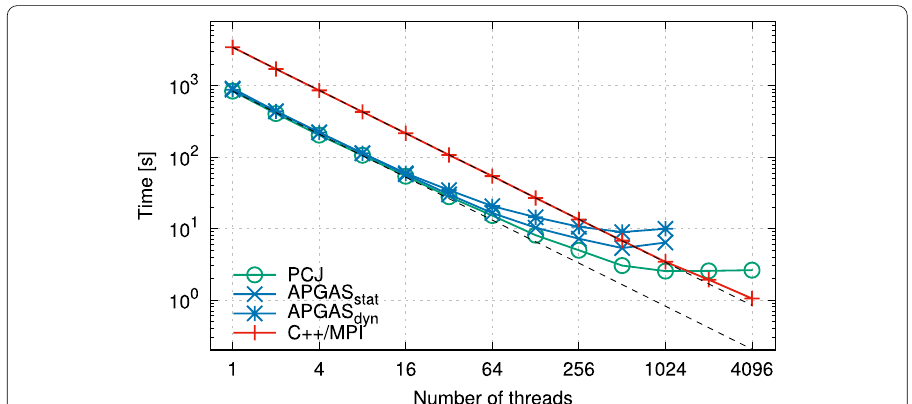
Fig. 7 Strong scalability of WordCount application implemented in PCJ and APGAS. APGAS stat and APGAS dyn denote original fork-join algorithm and algorithm using lifeline-based global load balancing. C /MPI ++ results are plotted for reference. Ideal scaling for PCJ and C /MPI are drawn with the dashed lines. The ++ results are presented for 3.3 MB file and were obtained using Cray XC40 at ICM. The APGAS results were not calculated for a number of nodes greater than 1024 due to long startup time exceeding one hour (which can be attributed to the library’s bootstrapper which—at the time of running the experiments—was not generic enough to offer a fast startup on a range of